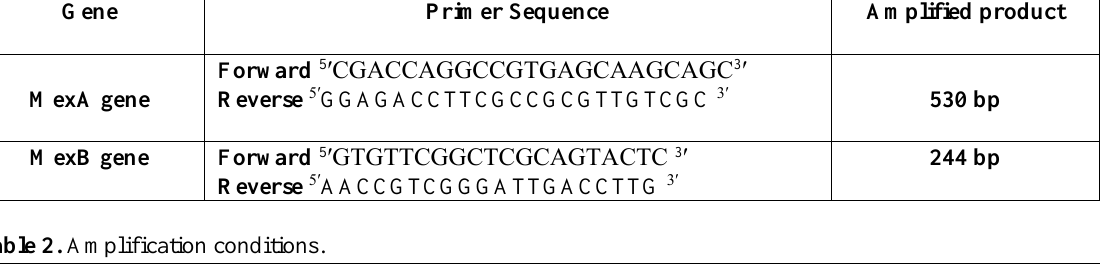
Table 2. Amplification conditions.